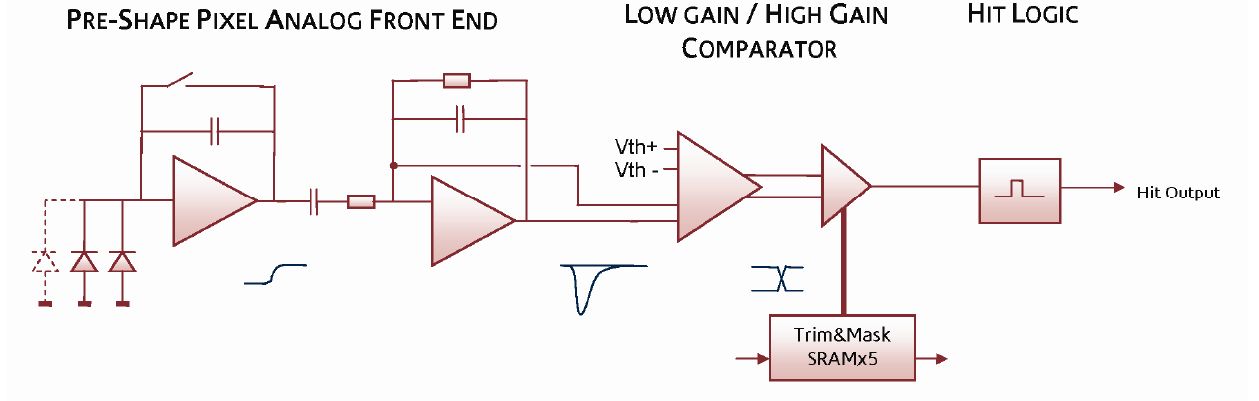
Figure 3. PreShape pixel block diagram showing the analogue signal path from collecting diodes to binary hit output.